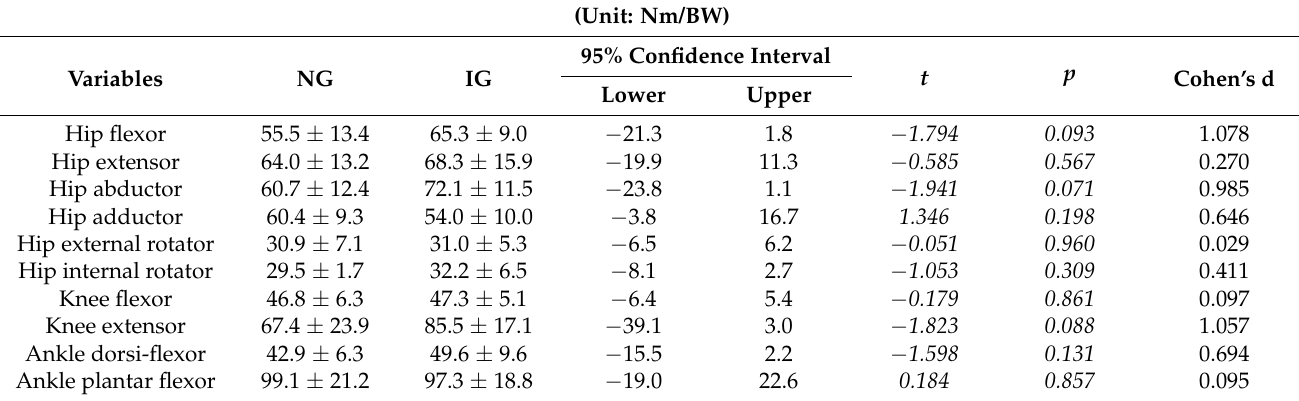
Table 2. Descriptive information for the lower extremities muscular strength of landing leg.